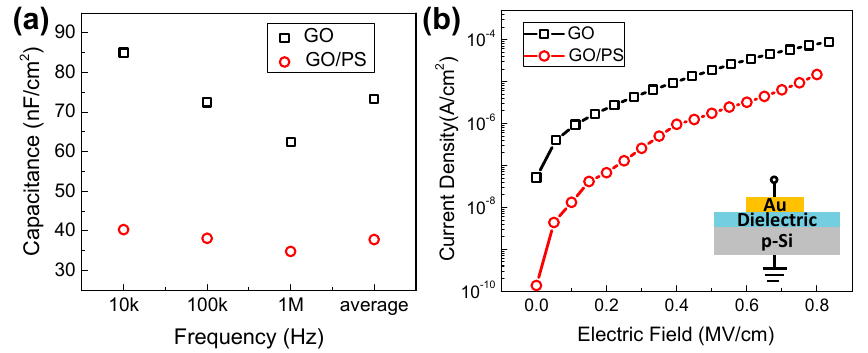
Figure 3. Analysis of dielectric properties of GO and GO/PS films: ( a ) frequency dependence of capacitance of GO and GO/PS films and ( b ) current density–electric field characteristics of GO and GO/PS films. The inset shows a schematic diagram of the metal–insulator–metal structure that induces the current density–electric field characteristics.